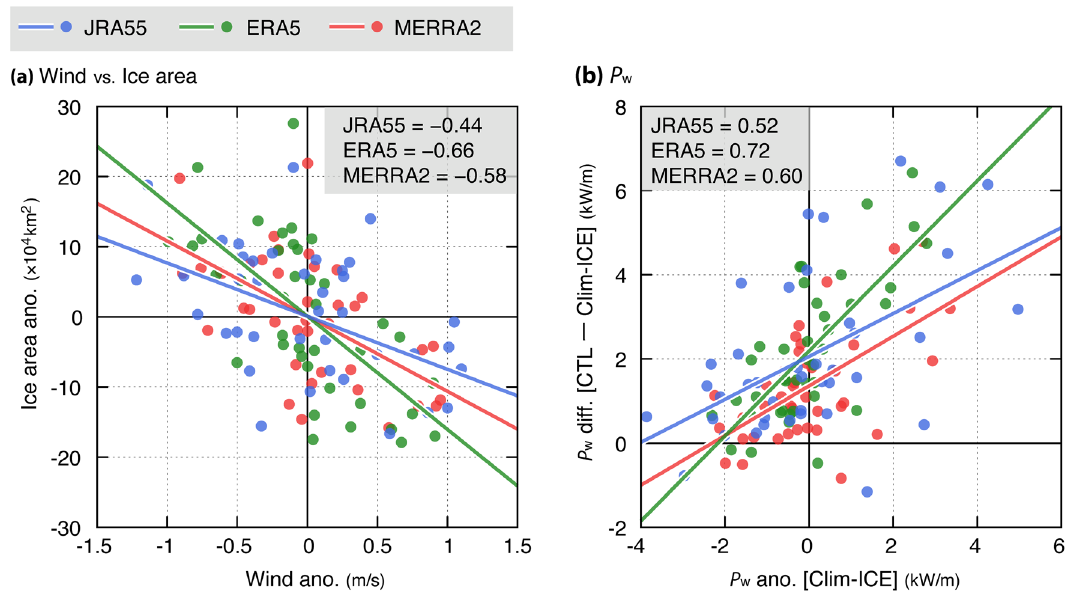
Figure 6. ( a ) Scatter diagram between inter-annual variabilities of surface wind versus ice area anomalies, over the SO during winter. ( b ) As in ( a ), but for the inter-annual variabilities of P w anomalies from the Clim-ICE run versus P w differences between the CTL and Clim-ICE runs. The anomalous values (i.e., inter-annual variabilities of surface wind, ice area, and P w ) are derived from winter mean minus winter climatological mean. ( a , b ) The bold lines indicate the regression line (JRA55, blue; ERA5, green; MERRA2, red). The correlation coefficients ( t -test, significant at p < 0.01) for ( a ) each reanalysis product and ( b ) model simulation are shown in the top corner of each panel (n = 40). ( a ) Note that the correlation coefficients for JRA55 are derived from the JRA55- derived surface wind and NOAA OI-derived ice area anomalies.